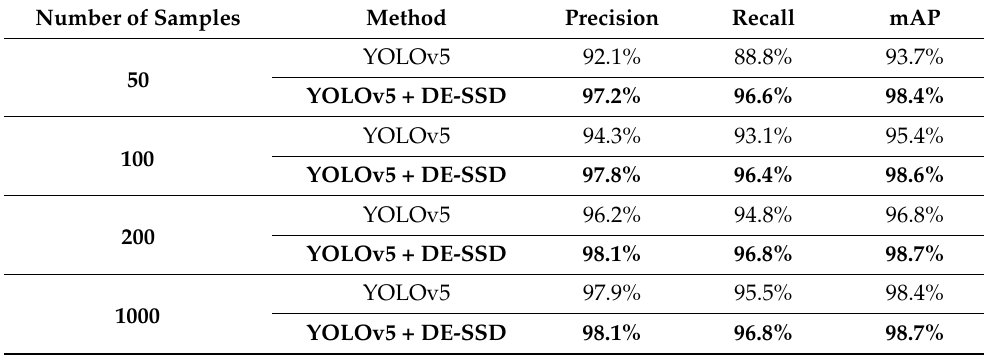
Table 2. Detailed information on comparison between DE-SSD method and baseline